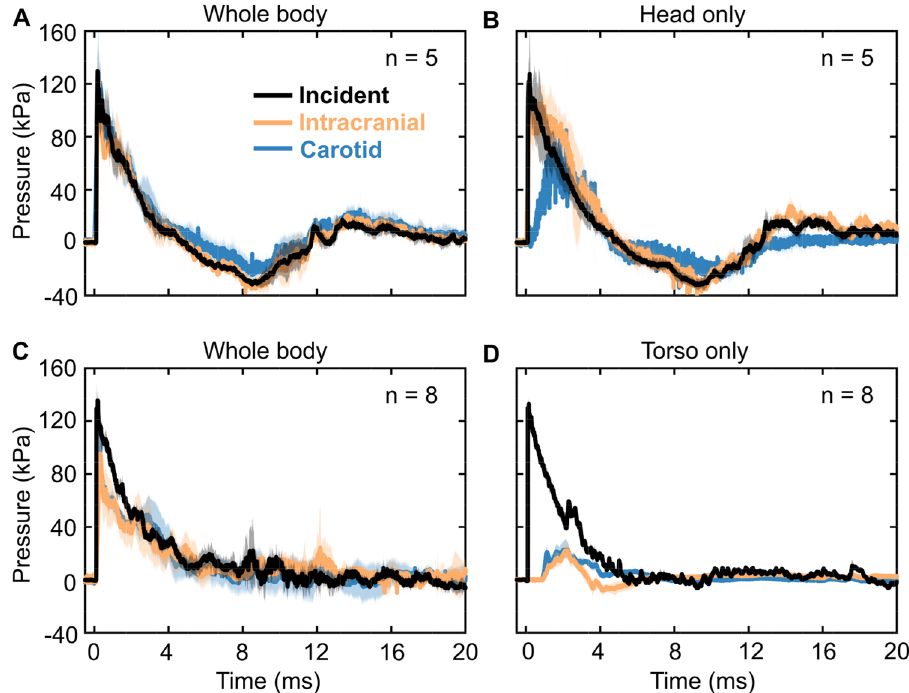
Figure 3. Pressure–time profiles of the incident, intracranial, and carotid-artery pressures for the ( A ) whole- body and ( B ) head-only blast-exposure experiments in the direct-mechanism study, and the ( C ) whole-body and ( D ) torso-only blast-exposure experiments in the indirect-mechanism study. The solid lines and shaded areas represent the mean and one standard deviation, respectively.